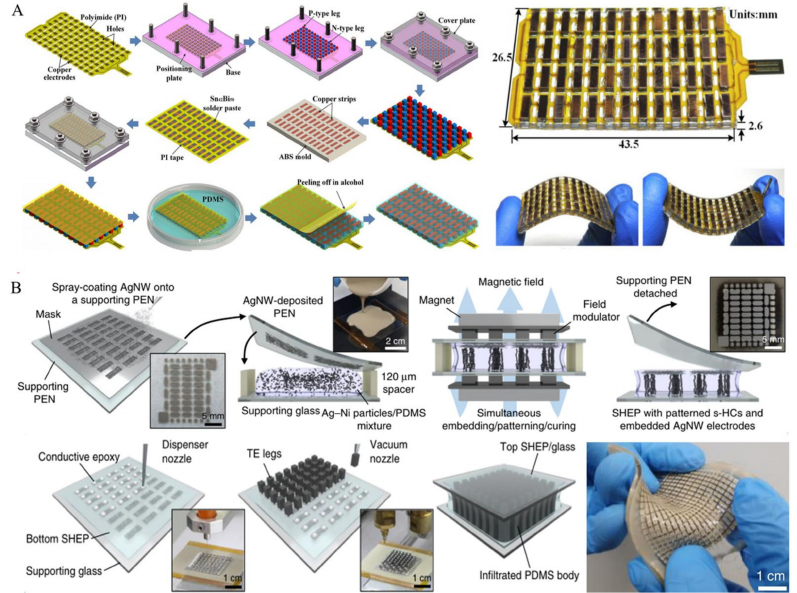
Figure 11. ( A ) Semi-automatic fabrication process for the wearable TEG based on FPCB and the fabricated device [58]. ( B ) Highly automated fabrication process for the wearable TEG based on AgNW electrode and the fabricated device